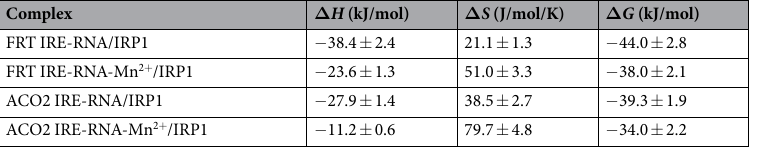
Table 2. Thermodynamic parameters of enthalpy ( Δ H ), entropy ( Δ S ) and free energy change ( Δ G ) for the interactions of FRT and ACO2 IRE-RNA with IRP1 protein in the absence and presence of 50 µ M Mn 2 +